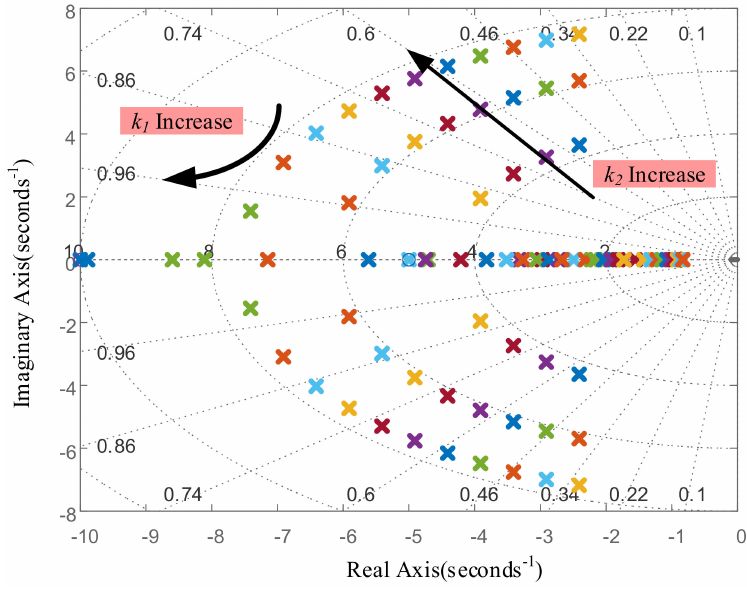
Figure 13. The zero-pole distribution of the system in SA